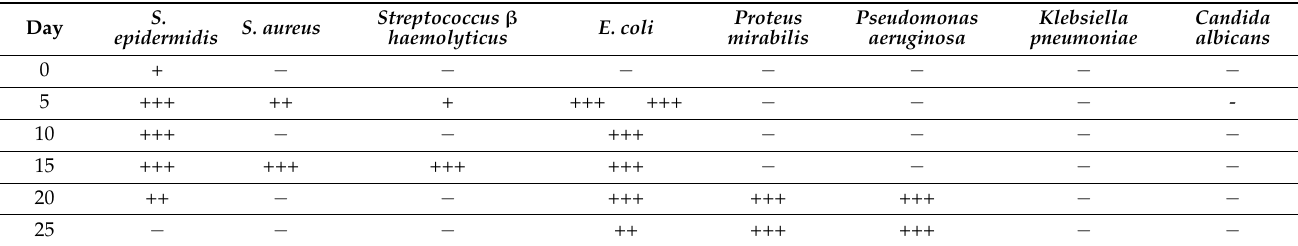
Table 5. Identification of pathogens grown from the wound treated with the ointment with 1% propolis and 1% nanosilver.